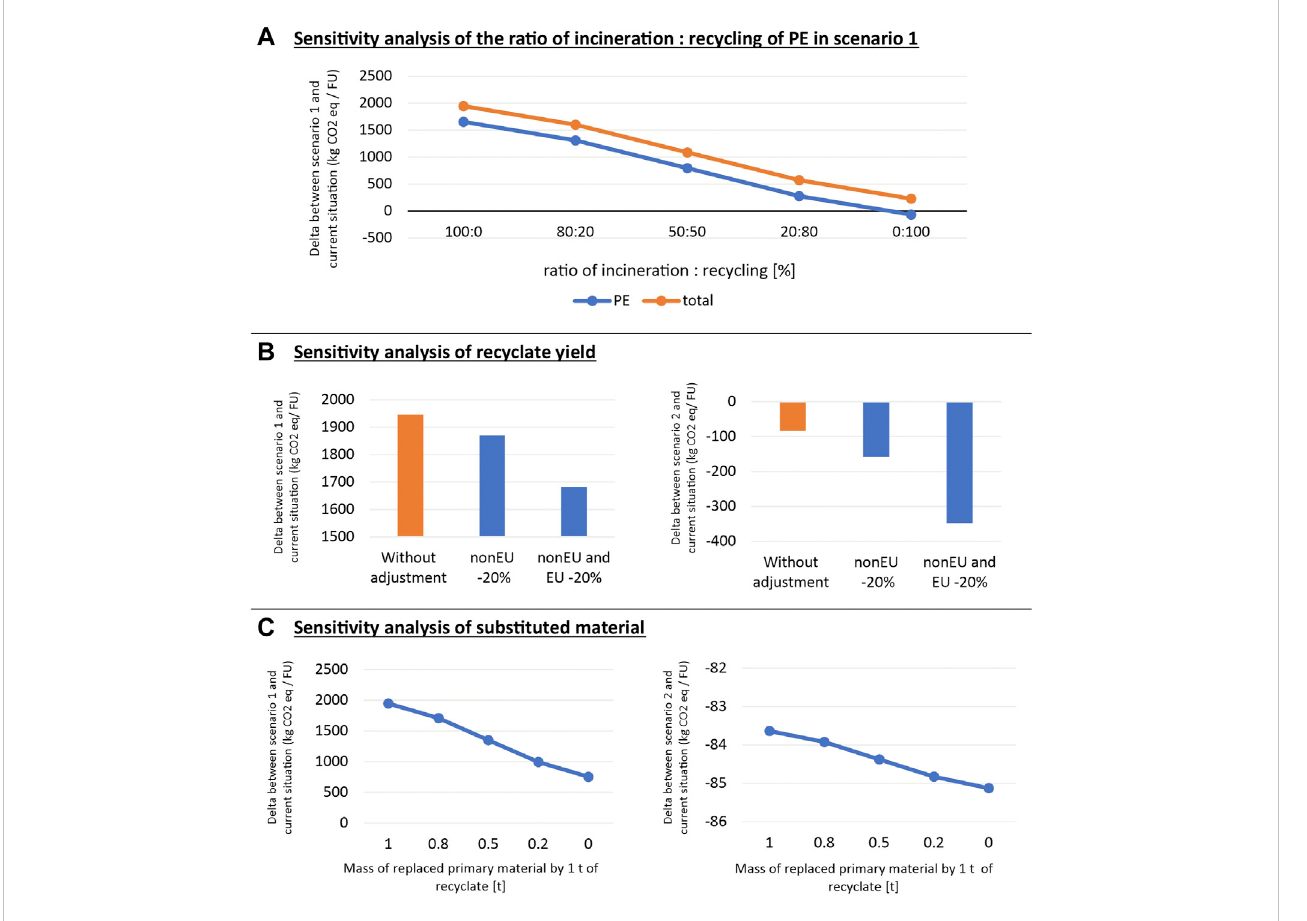
FIGURE 3 Sensitivity analysis for ratio of incineration to recycling of PE in scenario 1 (A) ; recyclate yield (B) and substituted material (C) .